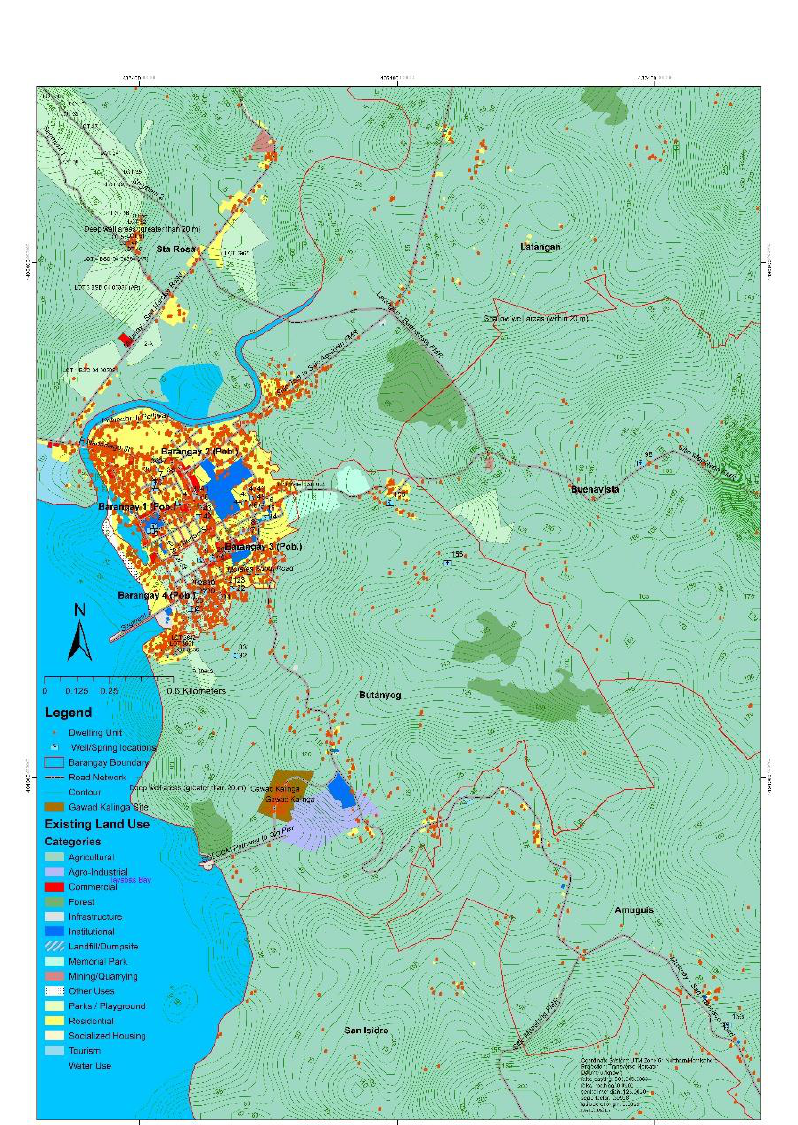
Figure A1. Topographic map of